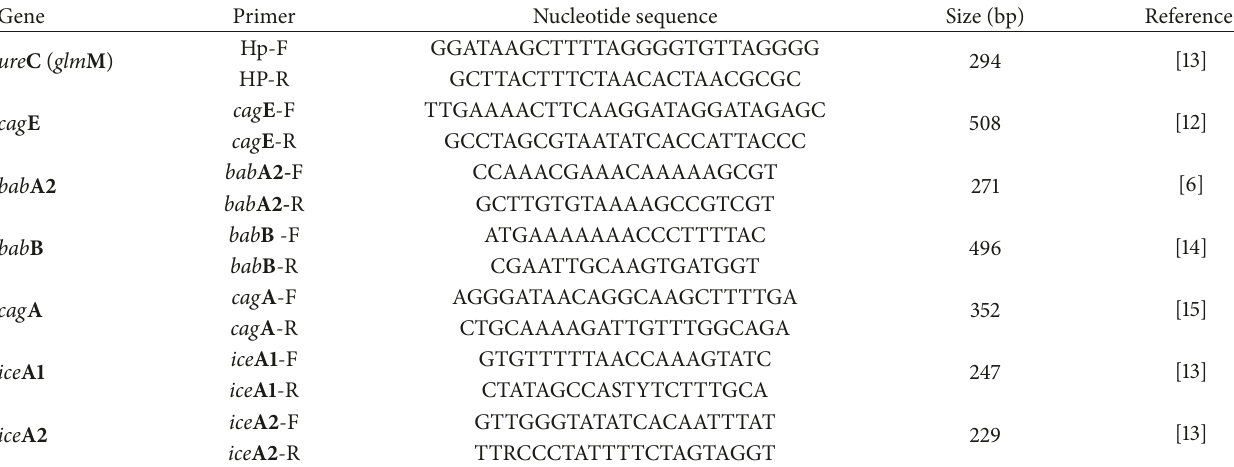
Table 1: Primer sequences for polymerase chain